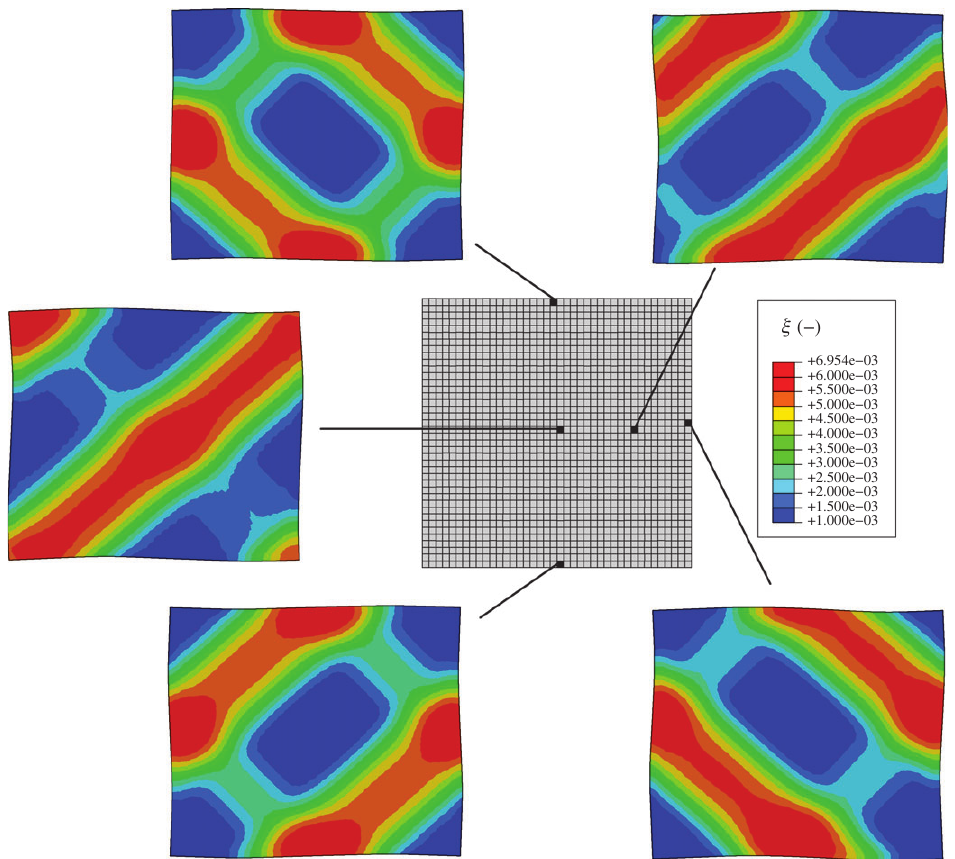
= 8% for different places 11